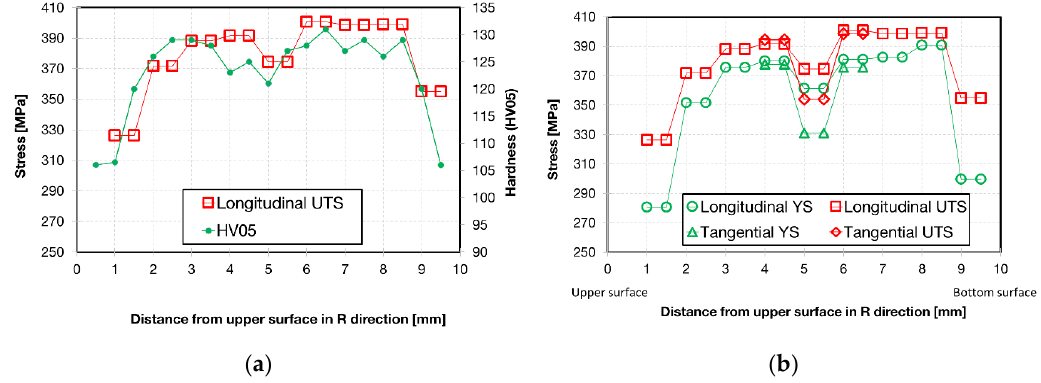
Figure 18. ( a ) UTS and HV05 profile over the wire cross-section; ( b ) YS and UTS profiles measured in longitudinal and tangential directions of the ECS sample.